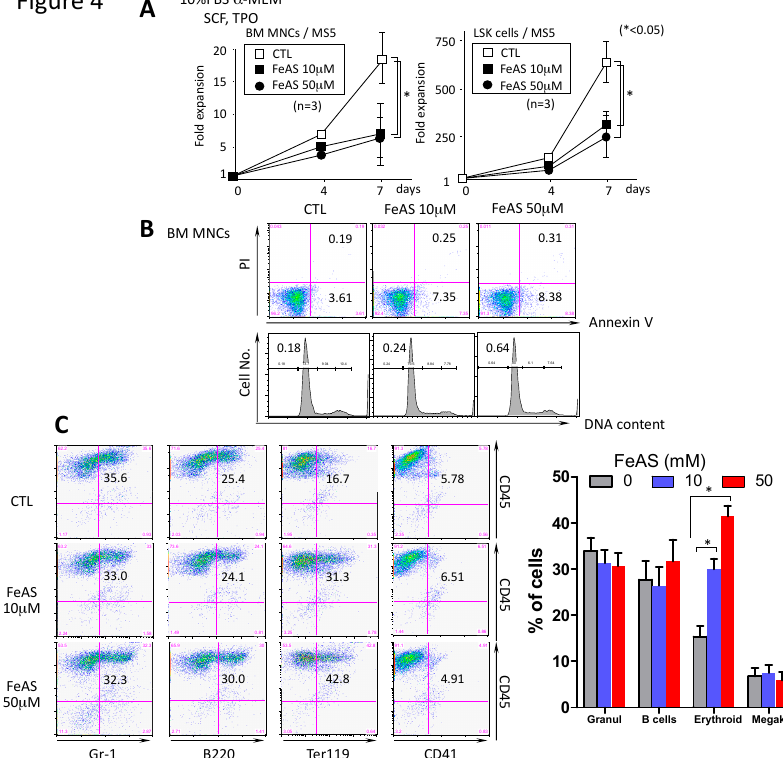
Figure 4. FeAS inhibits the growth of murine BM cells and modulates lineage distribution after culture with MS5 cells. ( A ) BM MNCs (1 × 10 4 cells) or LSK cells (100 cells/well) were co-cultured with MS5 cells under the indicated conditions for 7 days. Cell proliferation was determined by counting the total viable cells using the ATP assay. The data shown are representative of three independent experiments (* p < 0.05). ( B ) The proportion of apoptotic cells was determined with annexinV/PI-staining. The DNA content of cells cultured for 7 days was examined by PI staining. The proportion of cells in annexin V+ and the sub-G1 fraction is indicated, respectively. ( C ) After 7 days of culture, specific antibodies were used to characterize the surface phenotype of cultured LSK cells as indicated. Representative fluorescence-activated cell sorting data from one experiment are shown (left panel) and summarized data (mean ± SD) from three independent experiments is shown in the right panel (* p < 0.05) (Gr-1+ granulocytes, B220 B cells, Ter119 erythroid cells and CD41